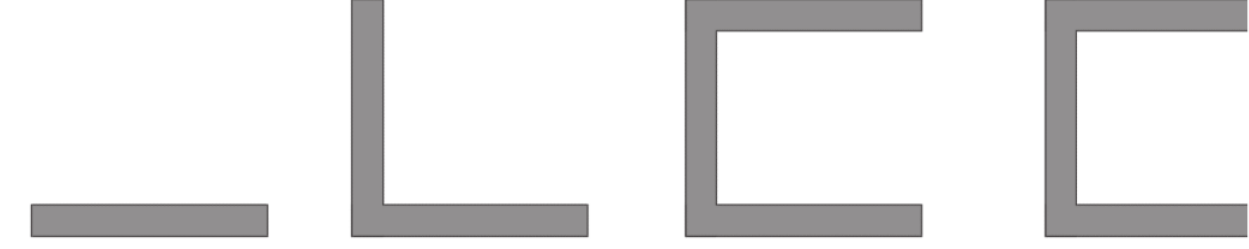
Figura 1 Exemplificação de geometrias da seção transversal de